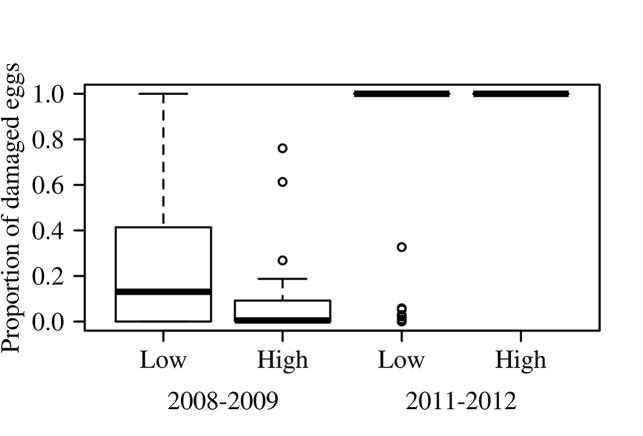
Proportion of L. olivacea eggs damaged at high and low nest densities on La Escobilla Beach, Oaxaca, Mexico, in the 2008–2009 and 2011–2012 arrival seasons.The line within each box represents the median, and the height of each box represents the first and third quartiles.